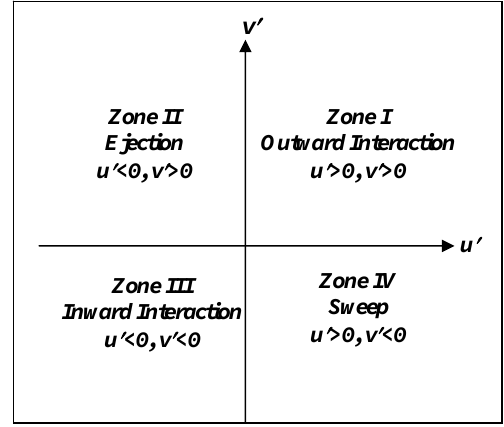
Figure 4- Four classes of bursting events and their associated quadrants Fig. 4. Four classes of bursting events and their associated quad- rants.